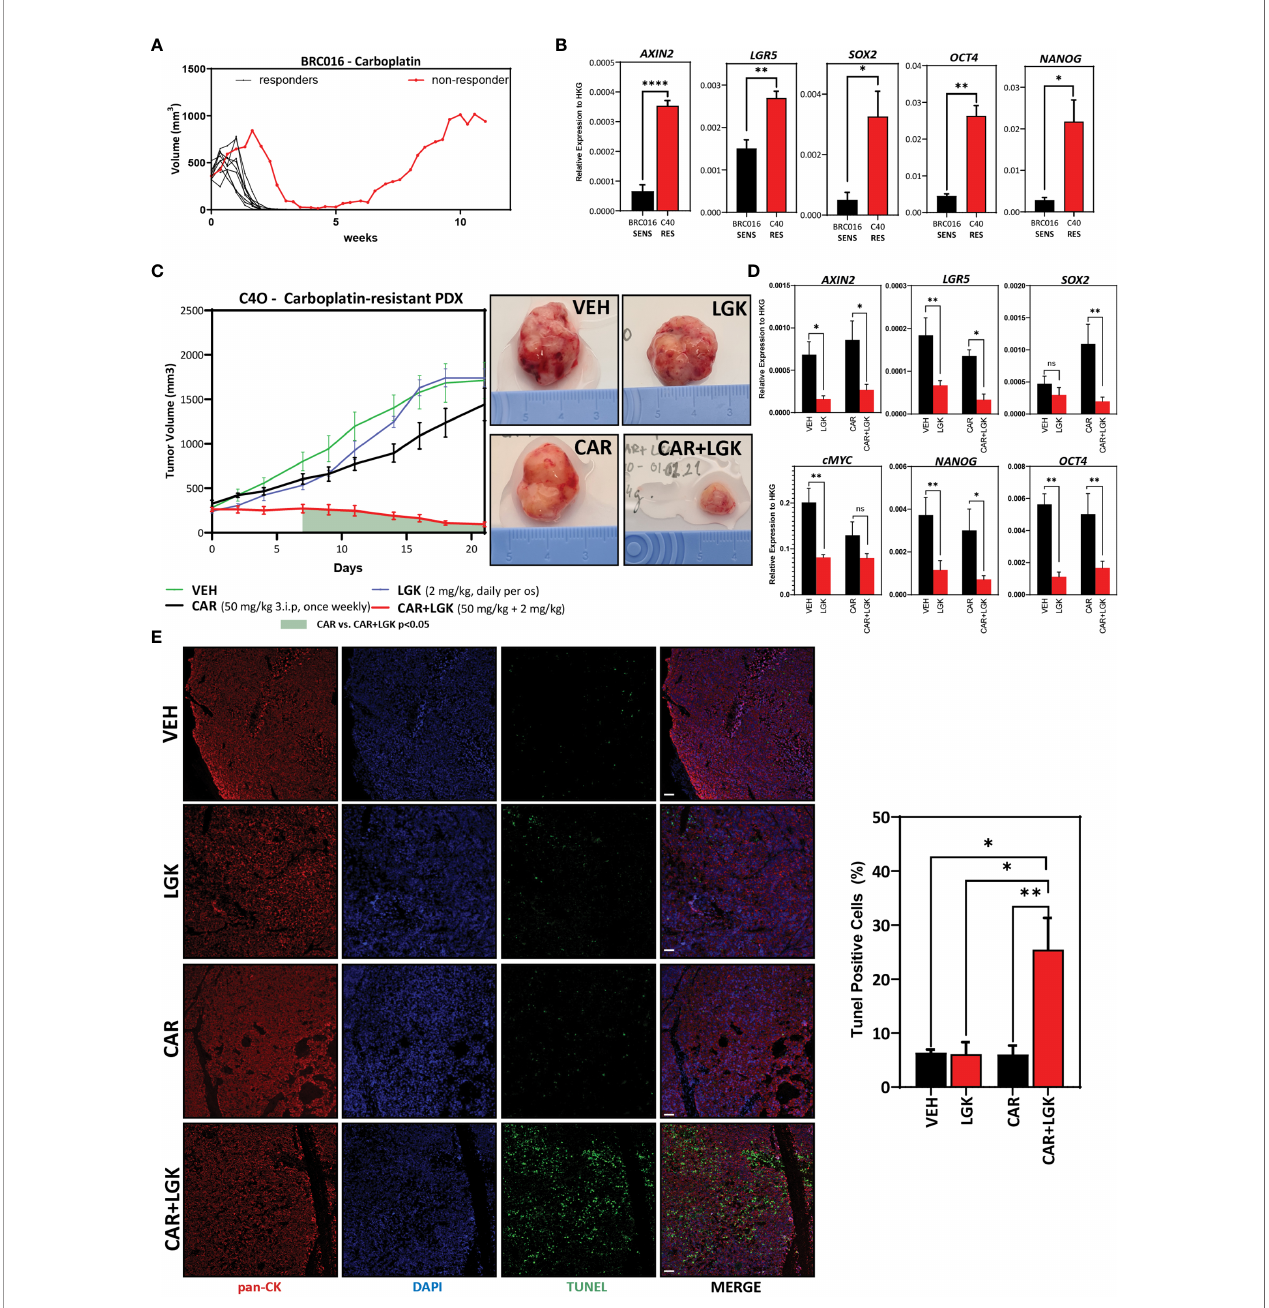
FIGURE 6 | WNT inhibition disrupts in vivo carboplatin-resistance in a carboplatin-resistant TNBC Patient-Derived Xenograft . (A) Tumor growth curves of carboplatin-sensitive BRC016 TNBC PDX model. Nine out of 10 mice show a complete response to treatment. One animal (red line) had a very delayed response and still had residual tumor mass after three weeks of treatment. The residual xenograft resumed growth after carboplatin treatment was stopped. This tumor was collected to establish a carboplatin-resistant model (C4O). (B) Comparative gene expression analysis by qRT-PCR of Wnt target AXIN2 and stem cell markers in BRC016 carboplatin-sensitive PDX and the C4O carboplatin-resistant isogenic PDX (n=4). Welch ’ s t-test. (C) Tumor growth curves of C4O carboplatin-resistant PDX treated with VEH, LGK974, CAR, or CAR+LGK showing reduced tumor growth in the combinatorial treatment arm (VEH, CAR, CAR+LGK n=6 and LGK n=5) (left). Two-way ANOVA with Tukey correction. The green-shadowed area under the curve represents highlights the time points in which the difference between CAR and CAR+LGK is statistically signi fi cant. Representative photographs of tumors in each treatment arm at day 21 of treatment (right). (D) mRNA level fold change (Log2) vs . VEH treatment (no carboplatin and no Wnt inhibitor) in tumors dissected at treatment endpoint (21 days) (n=3). Multiple t-tests (VEH vs . LGK and CAR vs . CAR+ LGK). (E) Representative confocal microscopy images (left) of TUNEL staining in green and human pan-cytokeratin immunolabeling in red and respective quanti fi cation and statistical analysis of TUNEL positive cells (VEH n=4, LGK n=4, CAR & CAR+LGK n=6). One-way ANOVA with correction for multiple comparisons using the Holm-Sidak method. (Barplots represent mean + SEM. * p < 0.05; **p < 0.01; ****p < 0.0001 ; ns, non signi fi